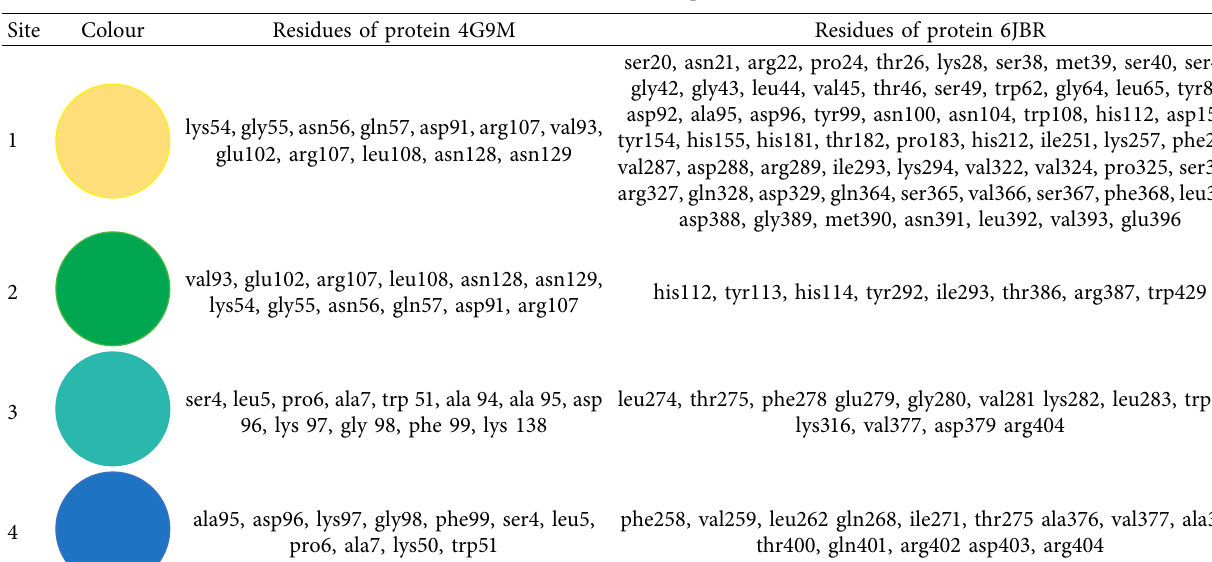
Figure 7: Quaternary structures of proteins (a) 4G9M and (b) 6JBR with their approachable sites by the investigated copper carbenes and copper silylenes: site 1 (yellow), site 2 (green), site 3 (cyan), and site 4 (blue). Table 3: In site amino acid residues of proteins 4G9M and